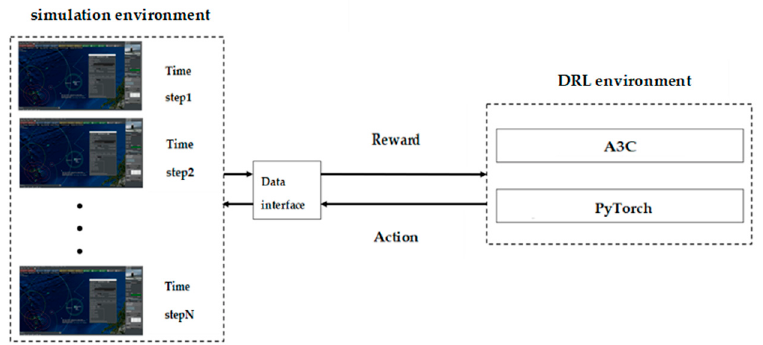
Figure 3. Simulation experiment environment.